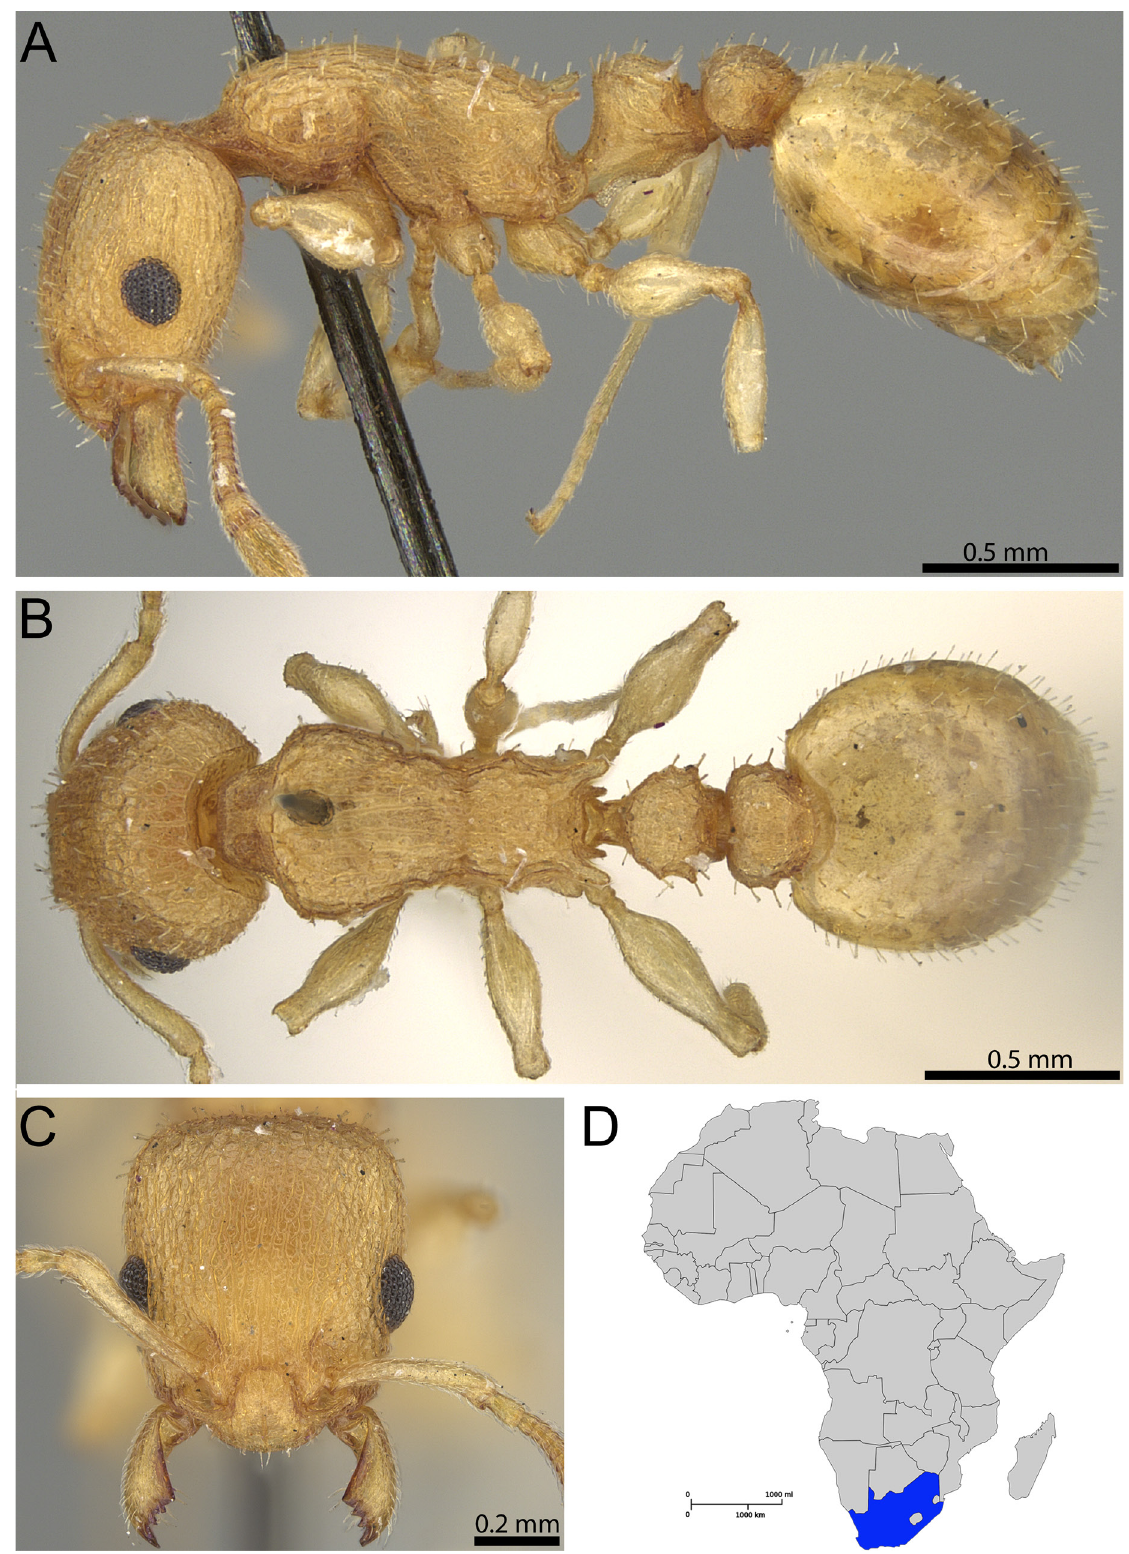
Fig. 15. Nesomyrmex denticulatus (Mayr, 1901) (CASENT0914923). A . Body in profile view. B . Body in dorsal view. C . Head in full-face view. D . Map of Africa and Madagascar showing currently known